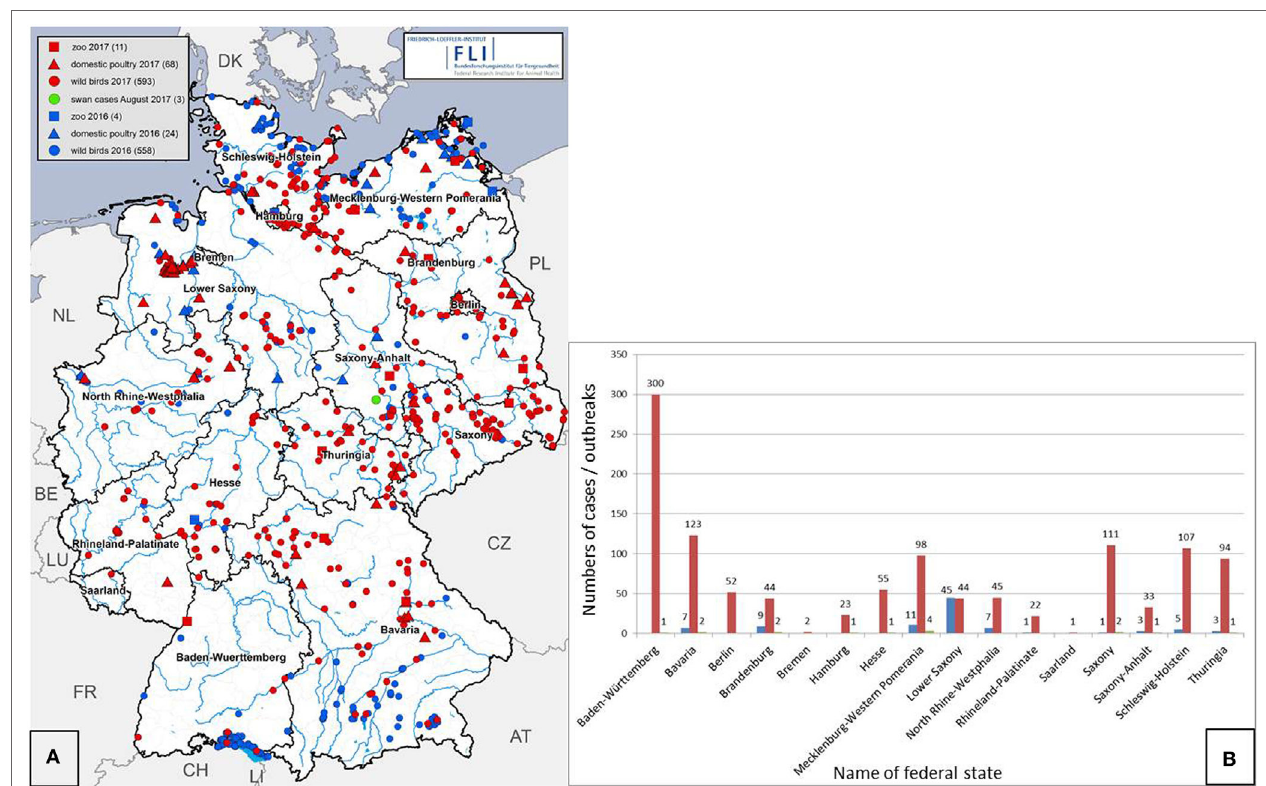
FigUre 1 | Reported highly pathogenic avian influenza (HPAI) clade 2.3.4.4b H5Nx cases in wild birds (points) and outbreaks in poultry holdings (triangles) and zoos (squares) in the German federal states in 2016 (blue) and 2017 (red). Green points refer to mute swans found HPAIV H5N8 infected in August 2017 (a) . Number of cases in wild birds (red) and outbreaks in poultry holdings (blue) and zoos (green) in each German federal state (B)